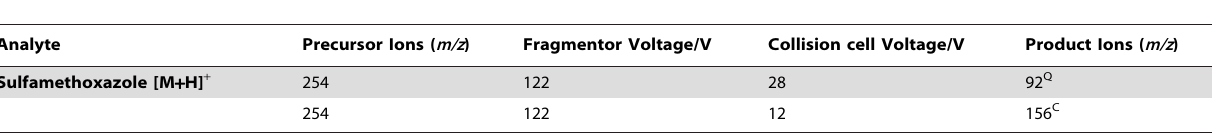
Table 2. Precursor ion, fragmentor voltage, collision cell voltage, and product ions for sulfamethoxazole MRM analysis.